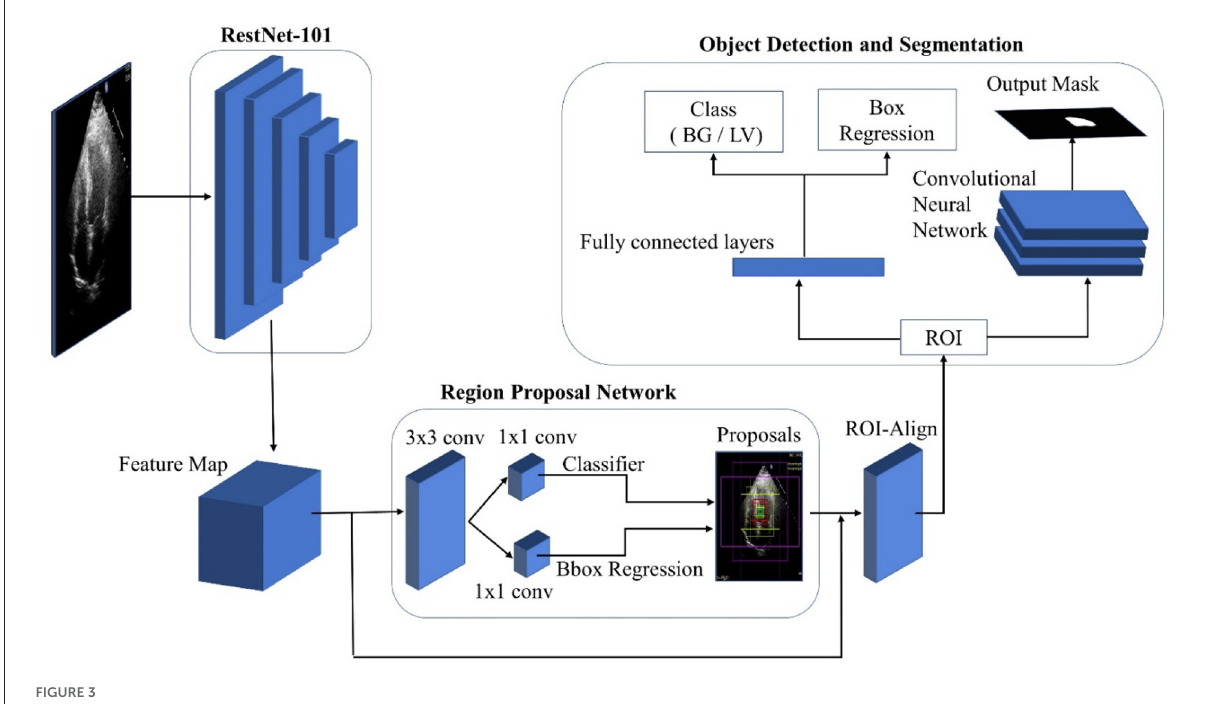
FIGURE3 Mask R-CNN